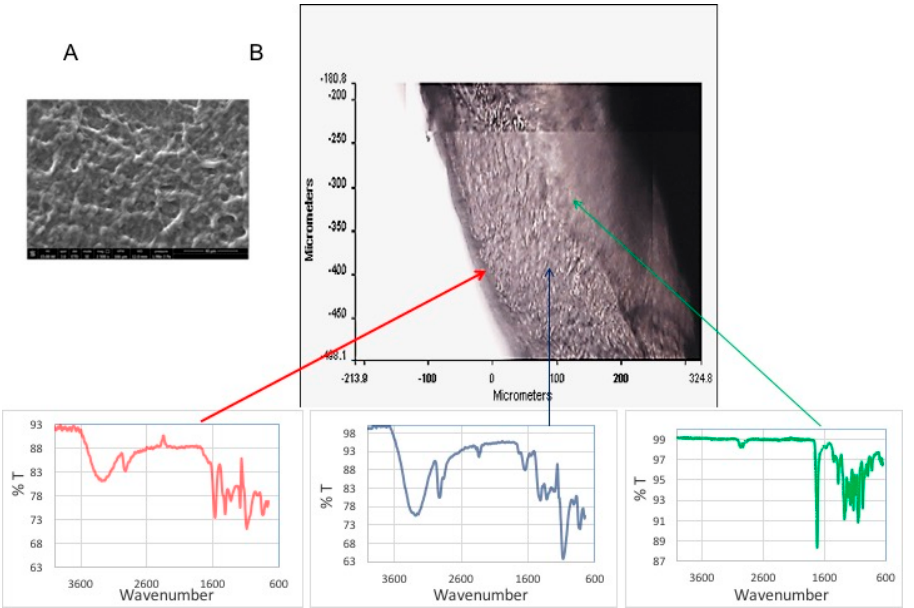
Figure 7. ( A ) SEM image of superior surface of multifunctional coating; ( B ) FT-IR chemical imaging: optical image of a section of three-layered coating (after forced detachment from a titanium substrate), the spectrum to the left of the optical image shows the P(VA-co-AA) bands, the spectrum below shows the PVA bands, and the spectrum to the right of the optical image corresponds to that of PHBHV.